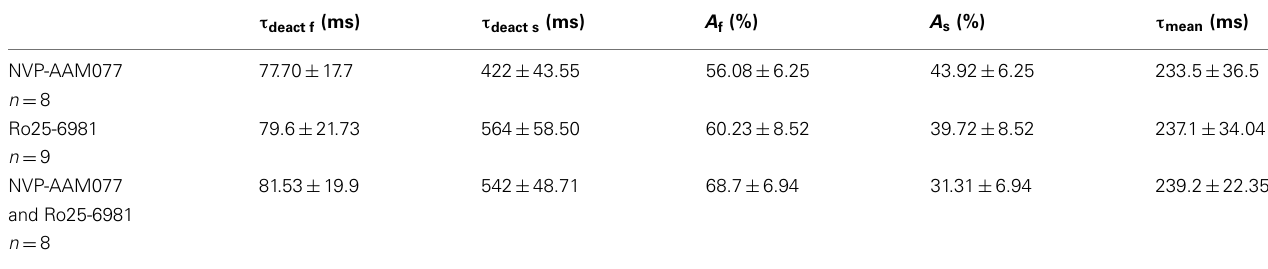
Table 4 | Decay time-constants of the NVP-AAM077-, Ro25-6981, and NVP-AAM077 + Ro-6981-resistent NMDAR currents in